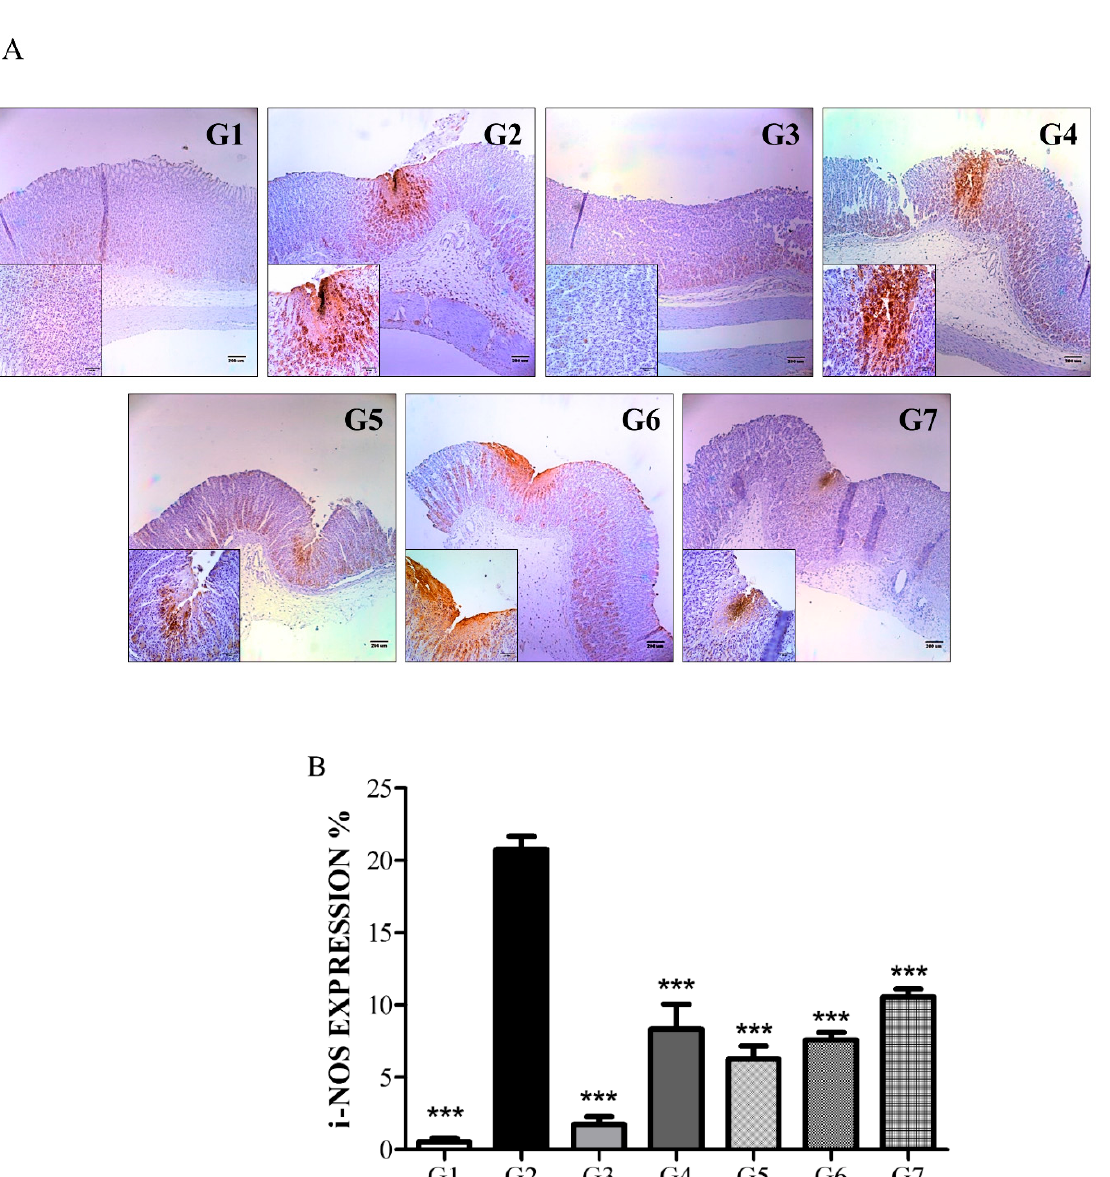
Figure 3. Immunohistochemical analysis: effect of phytoncide treatment on iNOS expression in indomethacin-induced gastric damage. ( A ) Photograph of stomach tissue from rat with indomethacin-induced gastritis, × 100 magnification. ( B ) iNOS expression graph of rat with indomethacin-induced gastritis. G1, normal control; G2, vehicle control (gastric ulcer control, indomethacin 80 mg/kg); G3, positive control (lansoprazole 30 mg/kg); G4, phytoncide oil 10 mL/kg; G5, phytoncide oil 5 mL/kg; G6, pine cone water extract 10 mL/kg; G7, pine cone water extract 5 mL/kg. *** p < 0.001 compared to vehicle control.